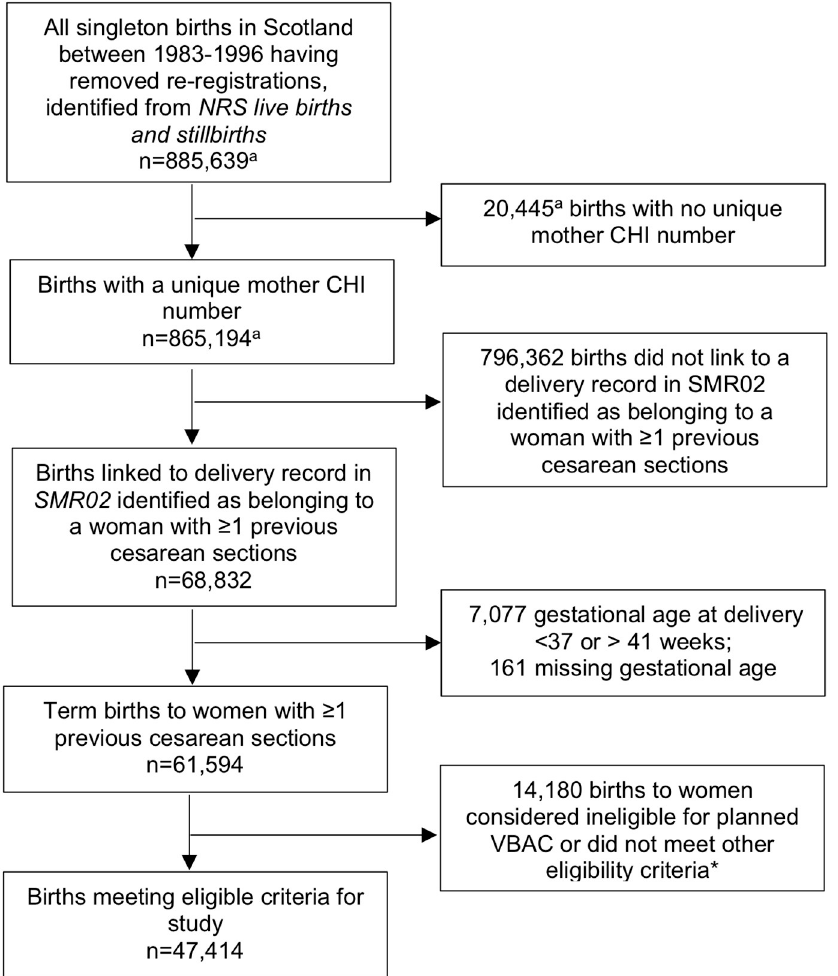
Fig 1. Flow diagram of cohort selection. � Ineligible for planned VBAC or did not meet other eligibility criteria for study due to 1 or more of the following: non-cephalic presentation at delivery ( n = 4,556); placenta praevia ( n = 546); abdominal pregnancy ( n = 1); known or suspected disproportion of maternal and/or fetal origin ( n = 6,593); tumor of corpus uteri ( n = 97); birth by pre-labor non-elective cesarean section ( n = 2,632); antepartum stillbirth ( n = 0); stillbirth missing time of death in relation to delivery ( n = 147); pelvic floor surgery before birth ( n = 28); missing information on mode of delivery ( n = 24); delivered by non-elective cesarean section missing information about duration of labor ( n = 927); number of previous cesarean sections greater than parity ( n = 15). Reasons not mutually exclusive. a Numbers provided by ISD Scotland, now part of Public Health Scotland. CHI, community health index; ISD, Information Services Division; NRS, National Records of Scotland; SMR02, Scottish Morbidity Record Maternity Inpatient and Day Case dataset; VBAC, vaginal birth after previous cesarean.